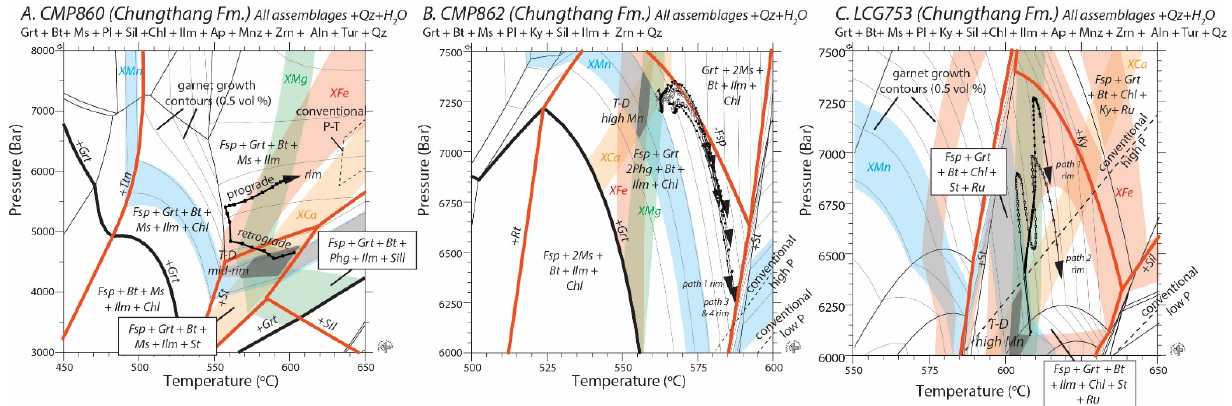
Figure 10. Isochemical phase diagrams and high-resolution P-T paths for Chungthang Formation samples ( A ) CMP860, ( B ) CMP862, ( C ) LCG753. Mineral assemblages for the samples are listed under the sample names. In each diagram, the colored bars represent isopleths ±0.2 mole fraction of the garnet composition from the highest Mn portion of the garnet. Blue = spessartine content, green = pyrope, orange = grossular, and red = almandine. Where these color bars intercept are the conditions for the highest Mn portion of the garnet. For sample CMP860, the composition was taken from the garnet mid-rim. Some reactions are labeled. We indicate relevant reactions that mark the appearance of index minerals with thicker lines.